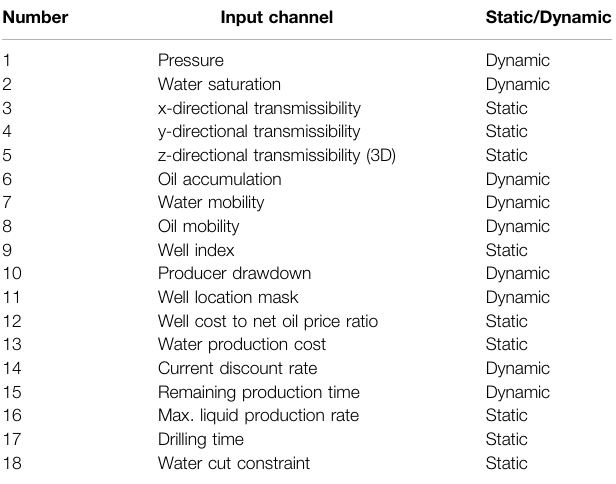
TABLE 2 | List of the input channels used to de fi ne the state for 2D and 3D oil- water system fi eld development optimization.